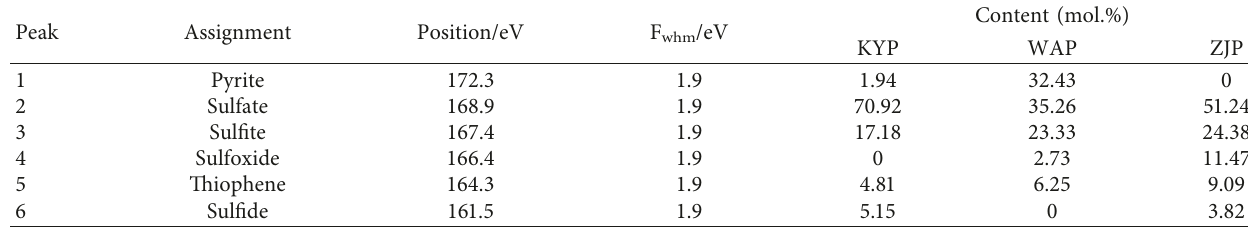
Figure 7: The XPS S 2p fitting curves: (a) ZJP, (b)WAP, and (c) KYP. Table 4: The XPS S 2p analysis of phosphate